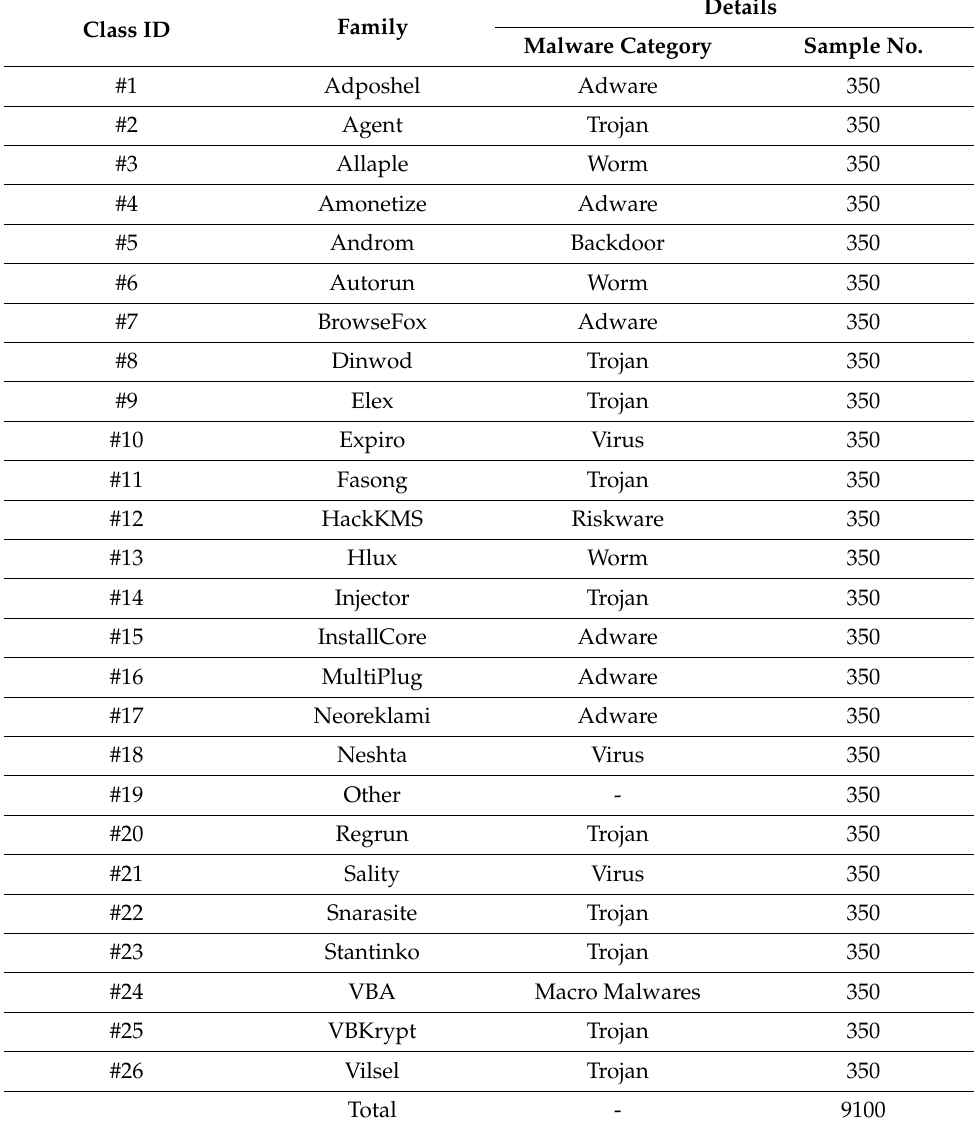
Table 2. Explanation of the MaleVis Dataset